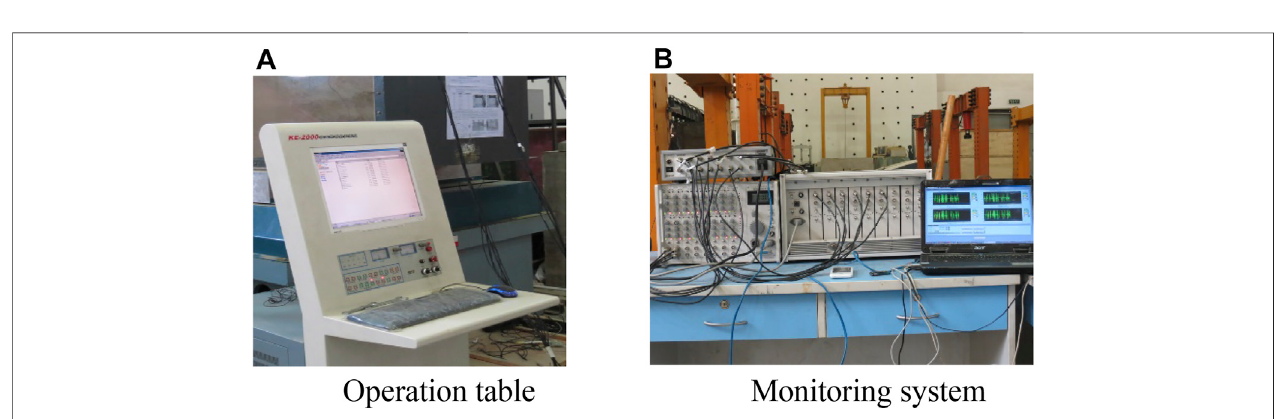
FIGURE 11 | Monitoring system. (A) Operation table. (B) Monitoring system.